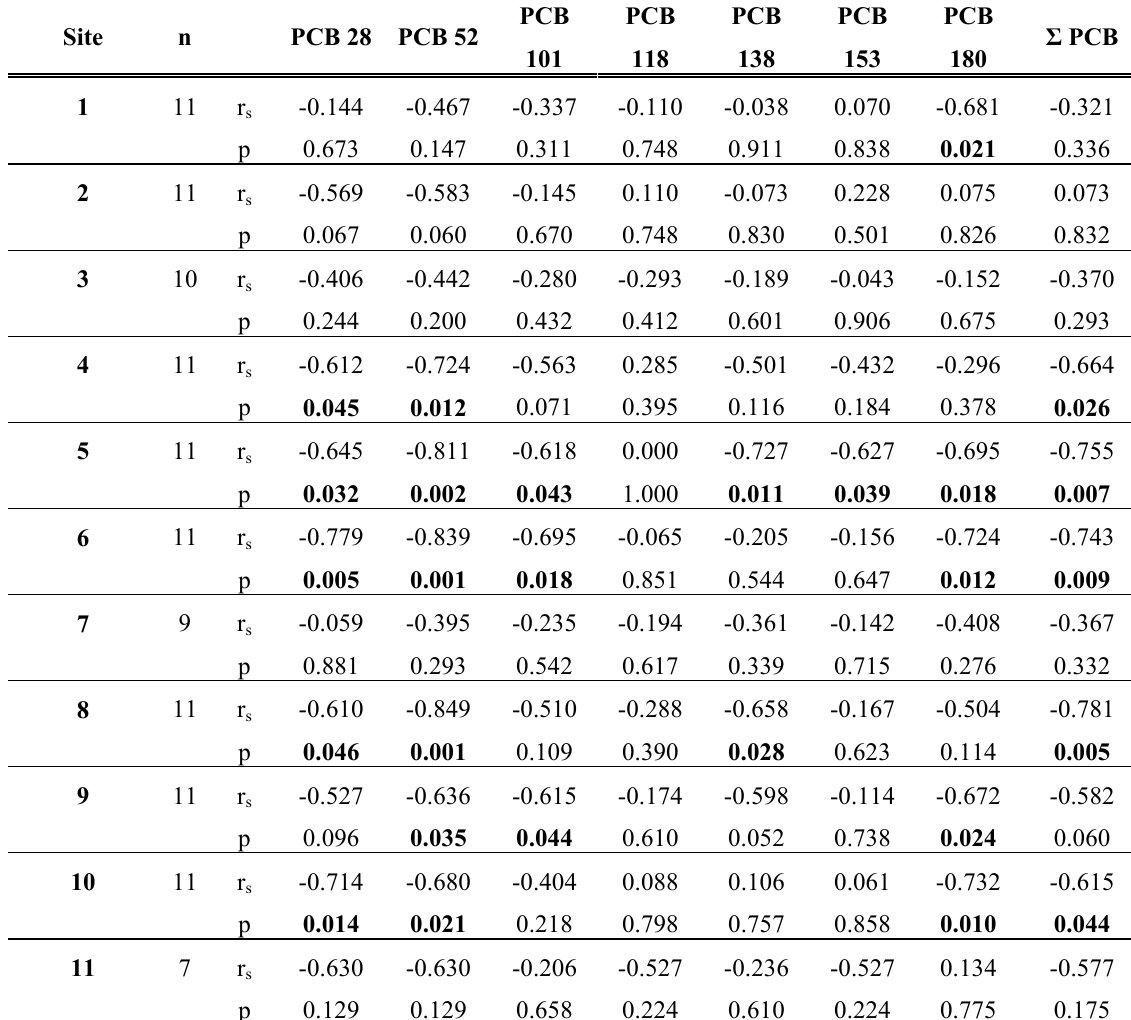
Table 3. Statistical relationship of PCB content from 1992 to 2003 (n = the number of Spearman rank correlation of time and PCB content, p years when leeches were sampled, r s - significance